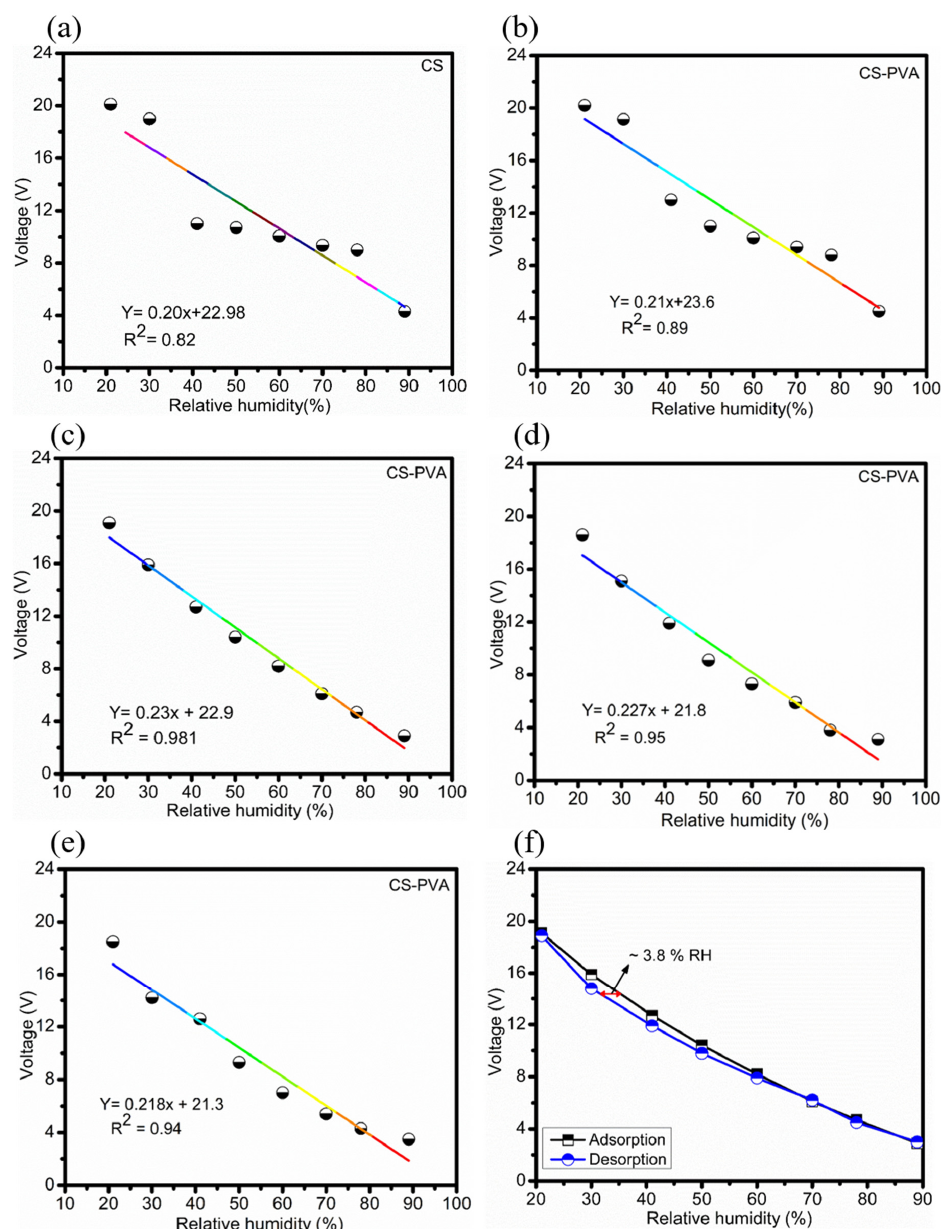
Figure 9. Sensitivity and linear relationships between the RH and voltage values of CS ‐ and CS ‐ PVA ‐ based HSs: ( a ) CS ‐ based HS, ( b ) 90/10 (CS ‐ PVA) HS, ( c ) 70/30 (CS ‐ PVA) HS, ( d ) 50/50 (CS ‐ PVA) HS, ( e ) 40/60 (CS ‐ PVA) HS, and ( f ) hysteresis curve of 70/30 (CS ‐ PVA) humidity sensor.